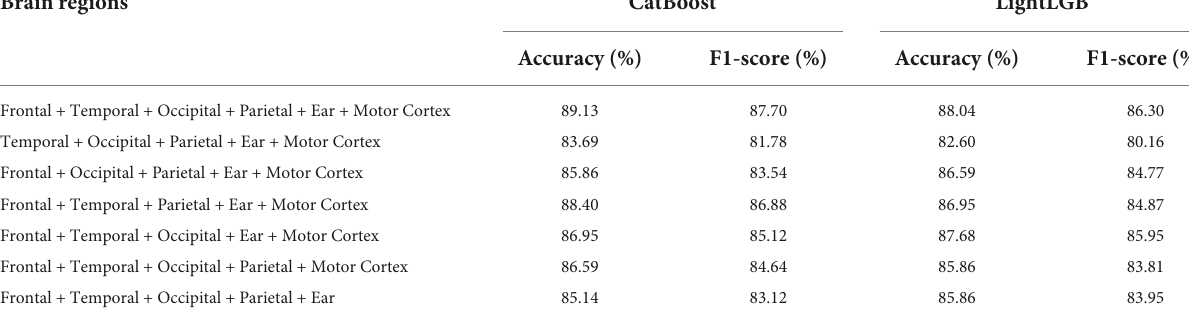
TABLE 6 Validating the effect of EEG electrodes on the proposed method performance. Brain